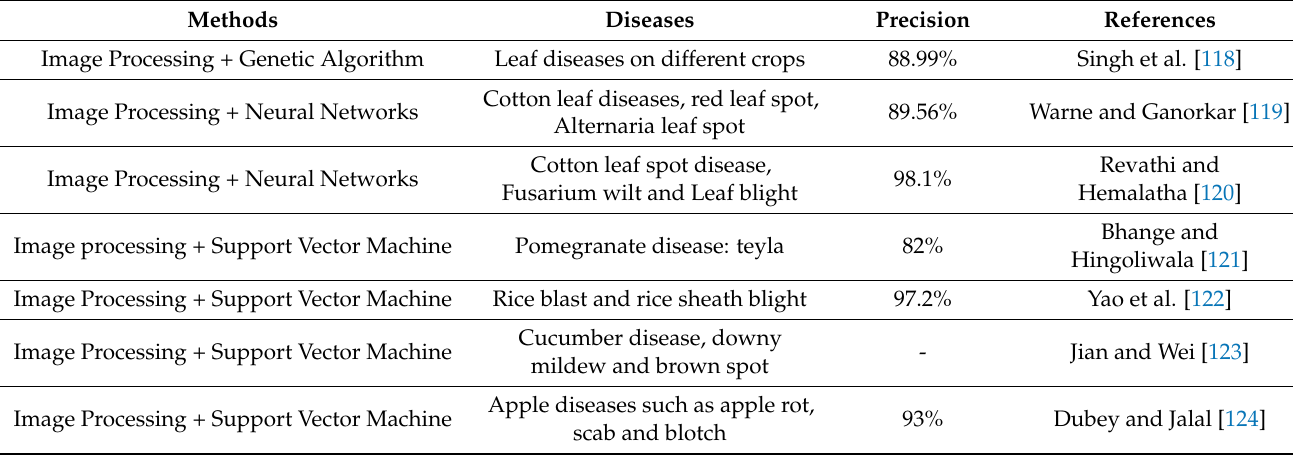
Table 4. Methods and precision percentage for detecting and classifying diseases in smart